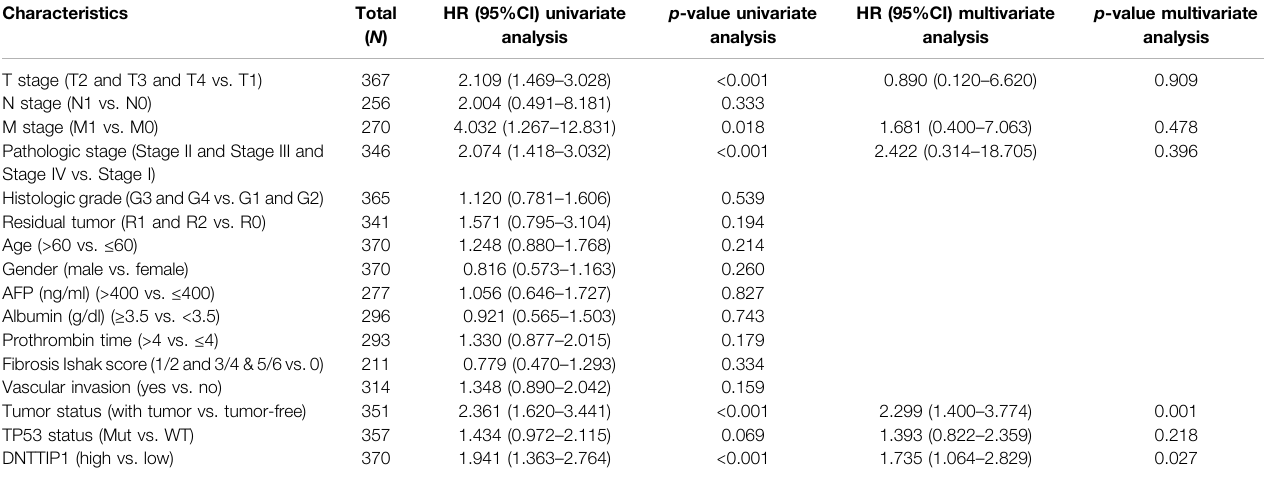
p -value univariate p -value multivariate HR (95%CI) univariate HR (95%CI) multivariate ( N ) analysis analysis analysis analysis